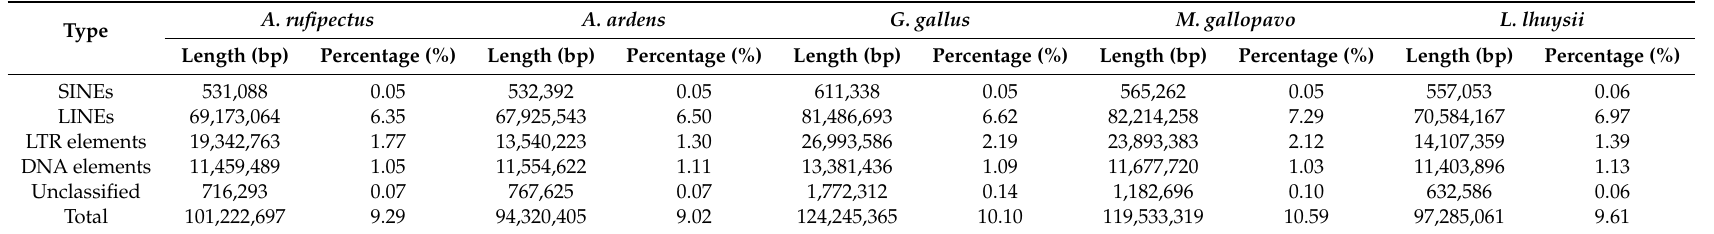
Table 2. Statistics of repetitive elements in five Phasianidae species.